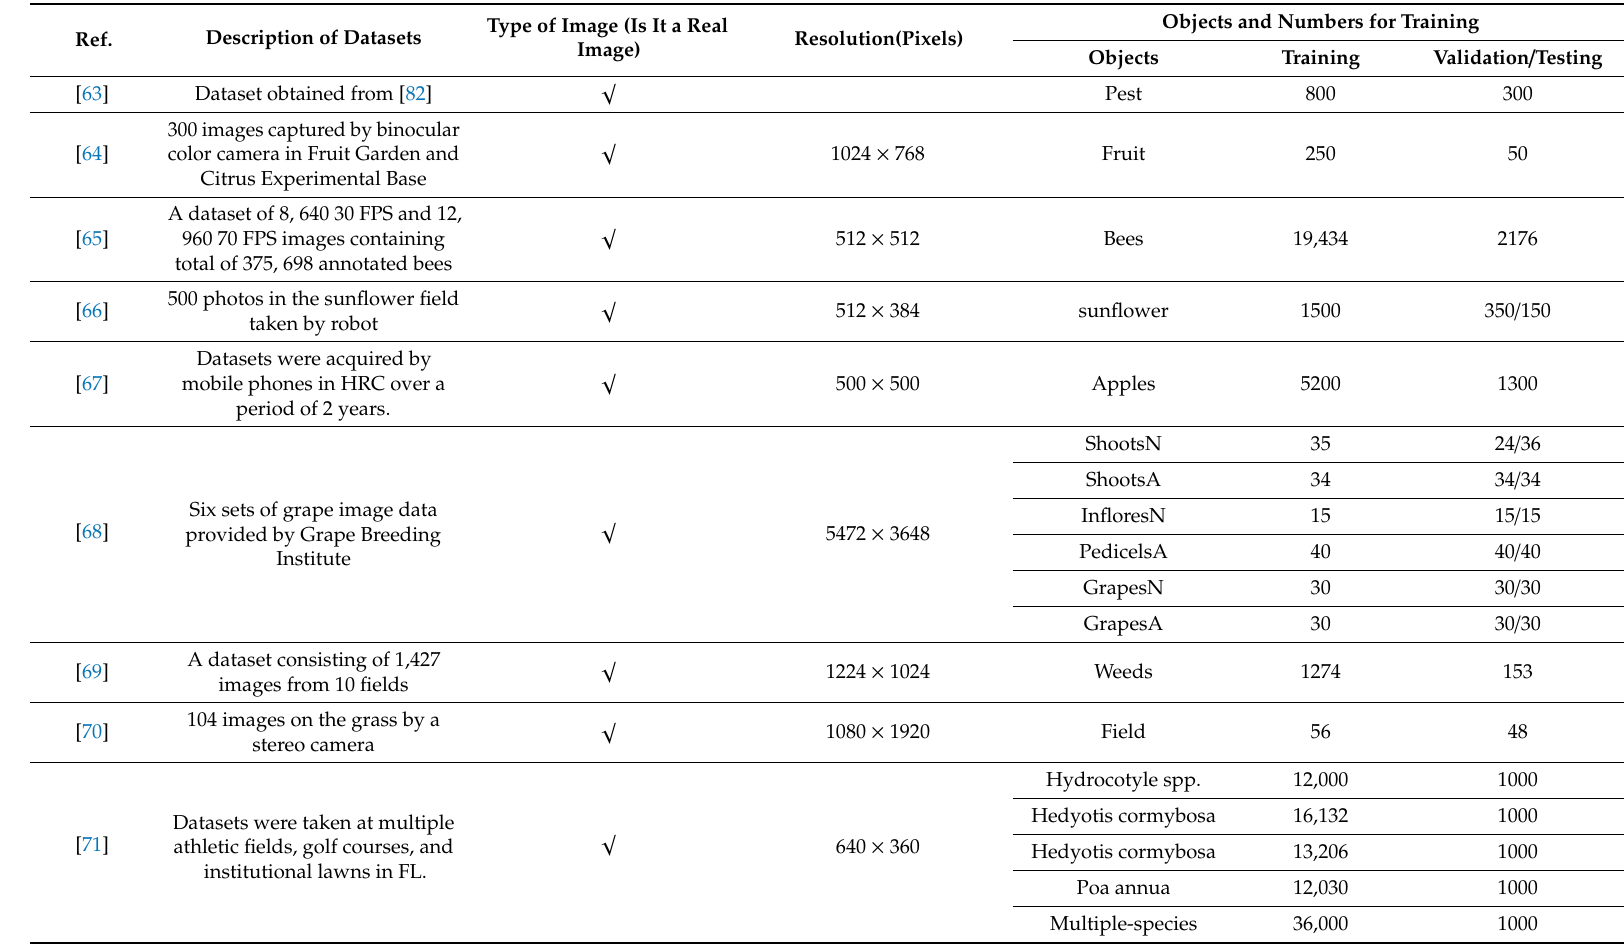
Table 3. Datasets in agricultural dense